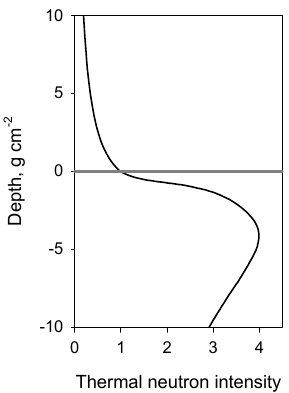
Fig. 14. Thermal neutron intensity near the air–water boundary cal- culated using the MCNPX code; the values are normalized to that at the